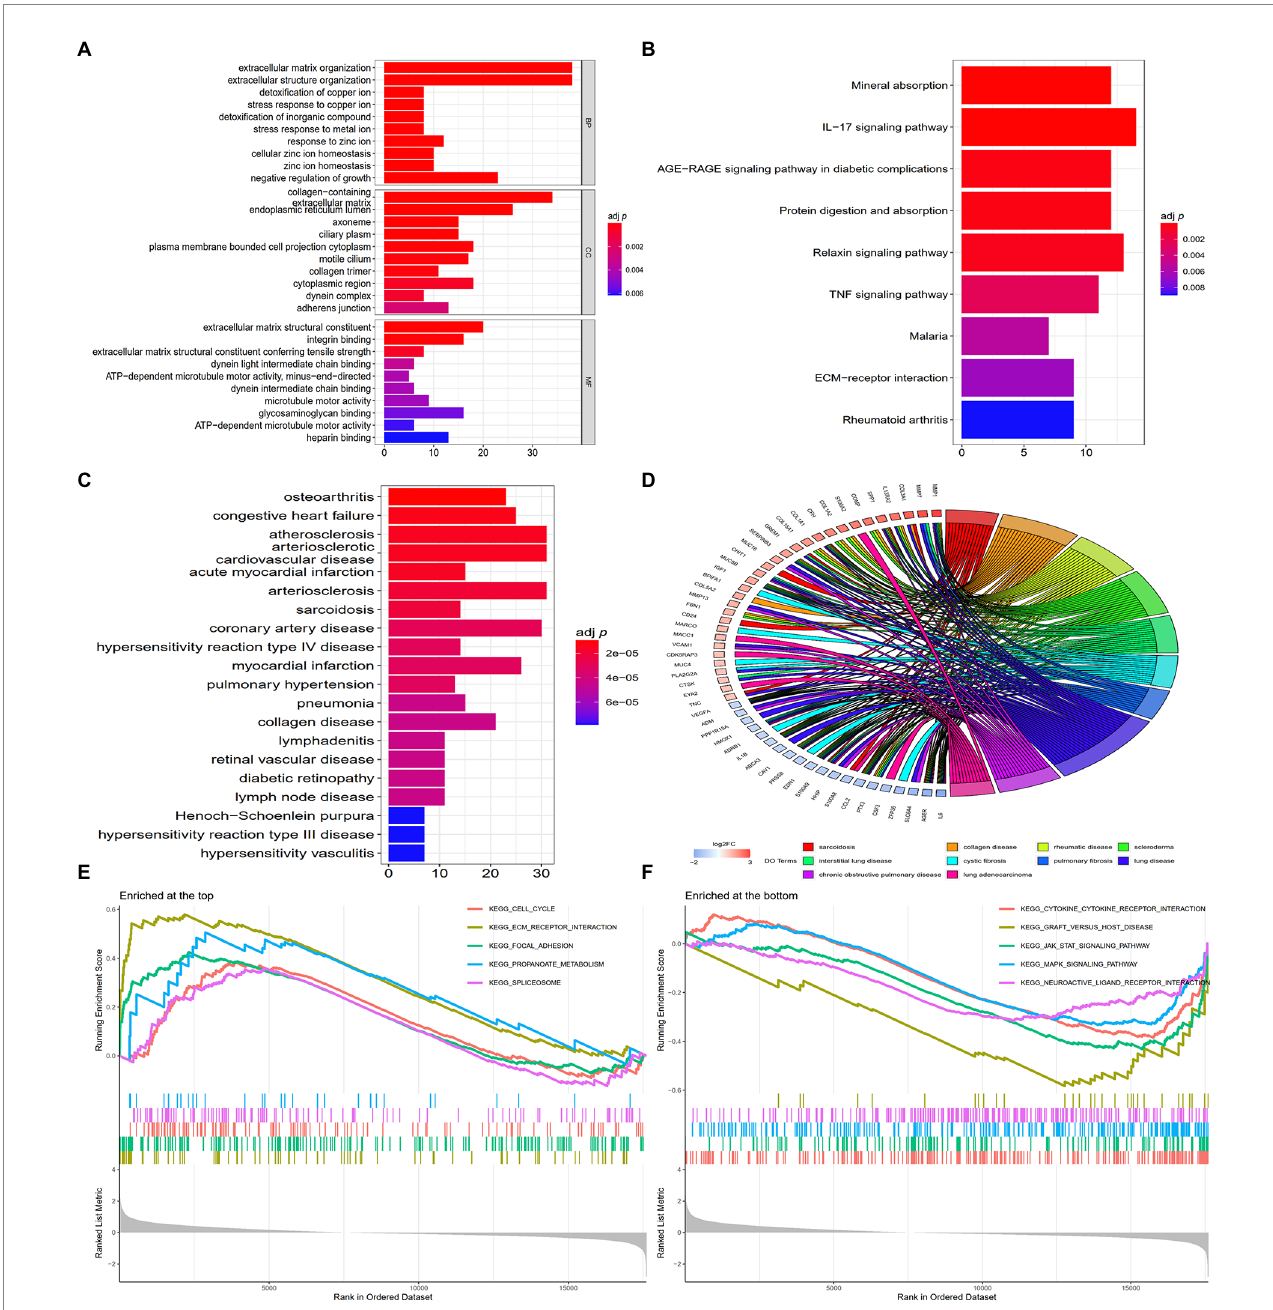
FIGURE 2 Enrichment analyses of DEGs. (A) The top 10 GO terms ranked based on their adj p -values. BP, biological process; CC, cellular component; MF, molecular function. (B) The nine enriched KEGG pathways. (C) The top 20 DO terms ranked based on their adj p -values. (D) Chord plot demonstrating the 10 main enrichments associated with IPF based on DO analysis, and gene names with the connection represent their enriched genes. (E) The 5 enriched gene sets at the top of the ranked list (NES > 1) indicate higher expression in IPF. (F) The 5 enriched gene sets at the bottom of the ranked list (NES < − 1) indicate lower expression in